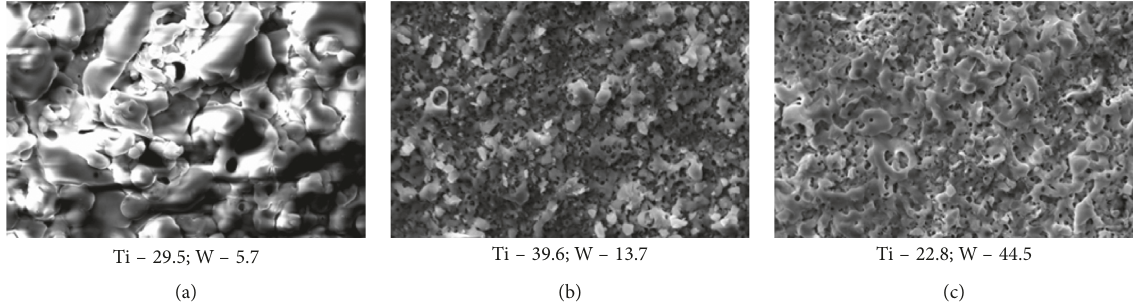
WO y oxide coatings: (a) at picks of clusters; (b) at valleys. ·